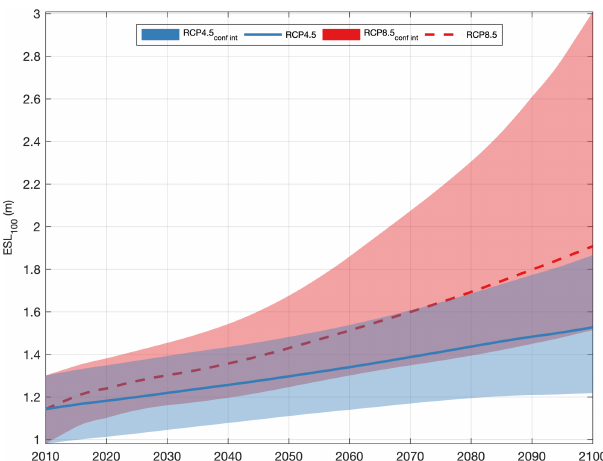
Figure 10. Time evolution of the 100-year ESL in the north-western Adriatic Sea under RCP4.5 (blue) and RCP8.5 (red). Lines show the corresponding medians, and coloured areas express the 5th–95th percentiles (very likely range). This figure follows the same graphic format, and it is based on the same simulations shown in Vous- doukas et al. (2017), but it specifically refers to the area marked with the red box in Fig.